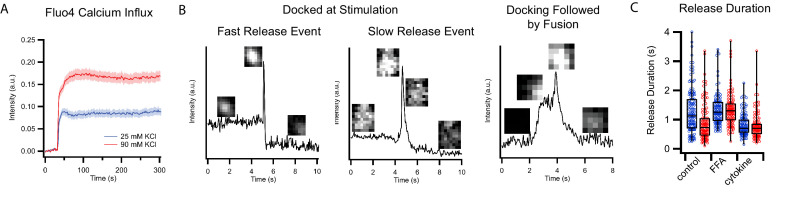
Calcium influx and single events of C-peptide-GFP release after KCl stimulation of GRINCH cells.(A) Fluorescence intensity of GRINCH cells labeled with cell permeable fluo4 at different depolarization strengths showing increasing amounts of calcium influx upon mild and strong depolarization. (B) Sample intensity traces for single events of C-peptide-GFP exocytosis of predocked granules from GRINCH cell illustrating fast or slow release, or a granule that is docking before release. These latter events are relatively rarely observed and excluded from our analysis. (C) Detailed plots showing release duration for all events that are summarized in the bar graph presented in Figure 2C.